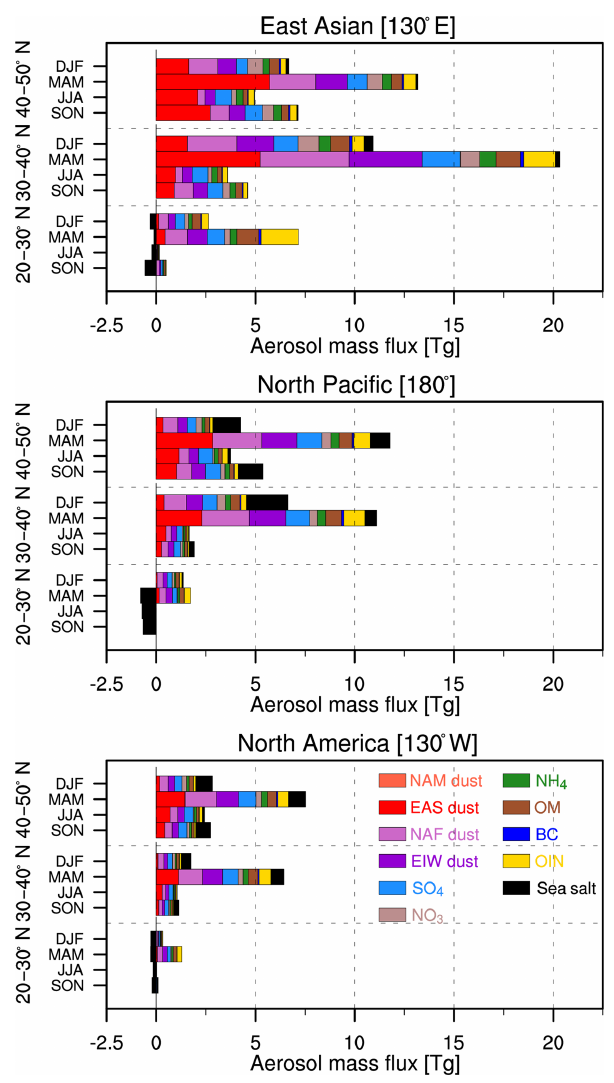
Figure 9. Meridional variations of East Asian outflow across the North Pacific and North American inflow of aerosol seasonal mass flux for